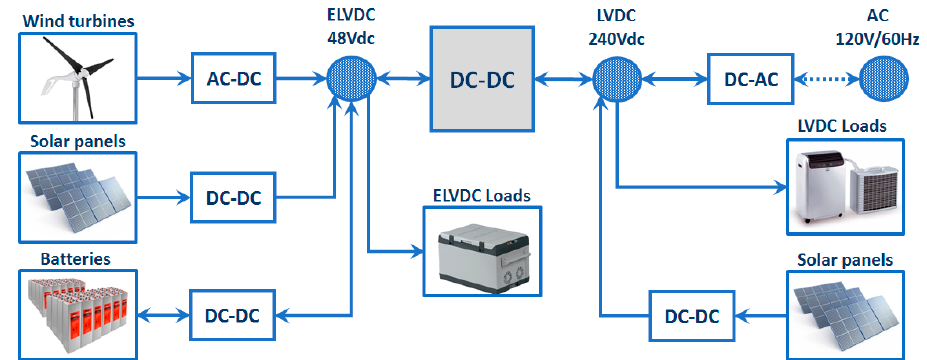
Figure 1. Hybrid microgrid architecture including extra-low-voltage DC (ELVDC) and low-voltage DC (LVDC) buses interconnected through a DC–DC bidirectional converter (MIREDHI Lab Project).